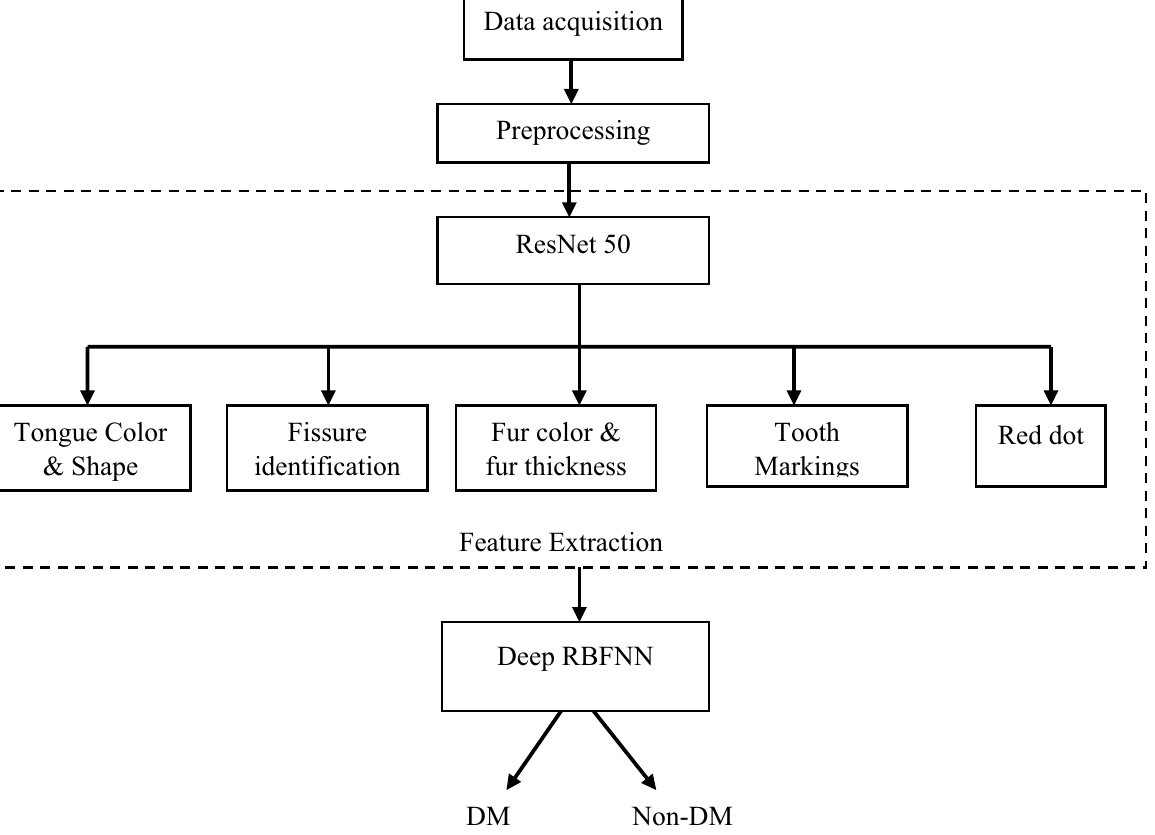
Figure 2. Block diagram of the proposed diabetes diagnosis research study with panoramic tongue imaging